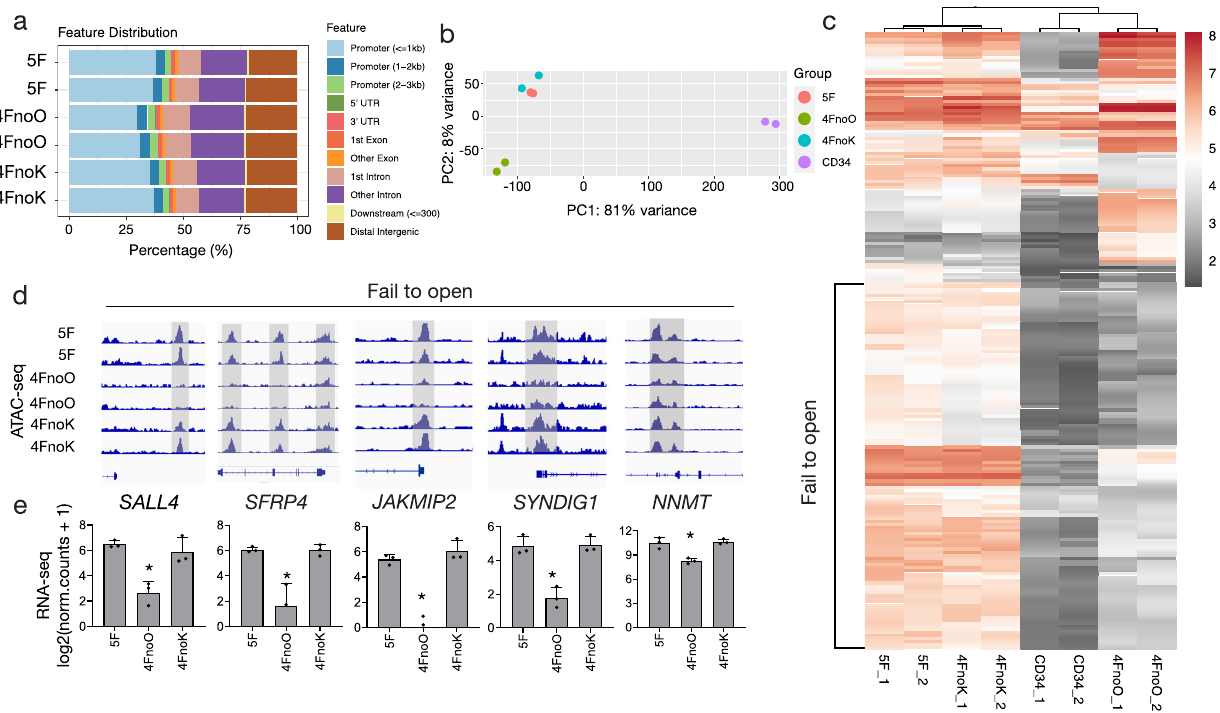
Fig. 5 Chromatin accessibility analysis of iMSCs reprogrammed with different factor combinations. a Genomic location of ATAC-seq peaks from 5F, 4FnoO, and 4FnoK iMSCs. b PCA using normalized ATAC-seq counts from 5F, 4FnoO, and 4FnoK iMSCs, and two datasets from bone marrow-derived CD34 + cells (SRR2920489 and SRR2920490). For each condition, the chromatin accessibility was pro fi led from iMSCs that were reprogrammed from two biologically independent donors. c Heatmap showing ATAC-seq signals with the top 200 most different peaks (ranked by padj). Red represents chromatin regions with more mapped reads, suggesting possible chromatin openness. Gray represents chromatin regions with fewer mapped reads, suggesting closed chromatin. d Selected genomic views of the ATAC-seq data using IGV (2.8) for the indicated groups. For each gene, all genome views are on the same vertical scale. e The bar plot showing RNA-seq gene expression values for the respective genes shown above in the genome view. RNA-seq gene expression levels are shown as log 2 () normalized read counts. n = 3 biologically independent samples for each group. * P ≤ 0.05; error bars indicate standard